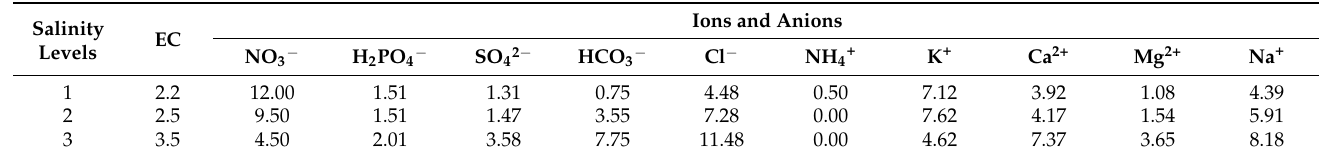
Table 3. Theoretical final irrigation nutrient solution composition for each treatment. EC, electric conductivity for treatment (dS m − 1 ); ions and anions of interest for irrigation (mmol l − 1 ).